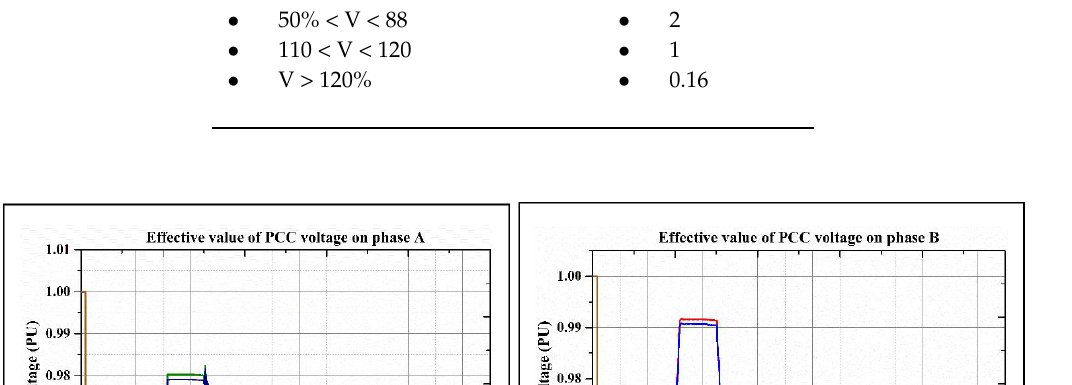
Figure 19. The frequency variations during grid faults occur. Table 3. Voltage relay responses. Voltage Range (% of Base Voltage)